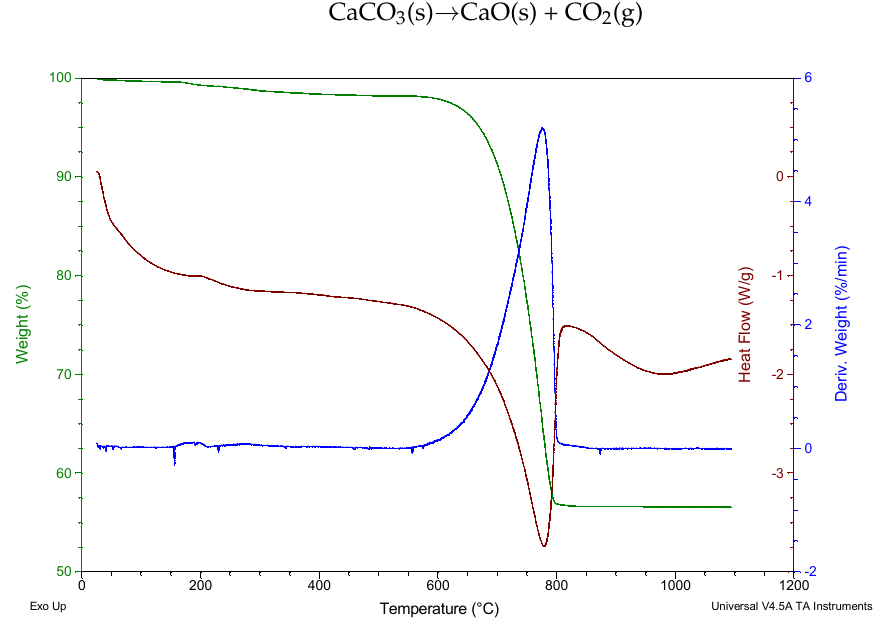
Figure 1. Thermogravimetric analysis of WS.